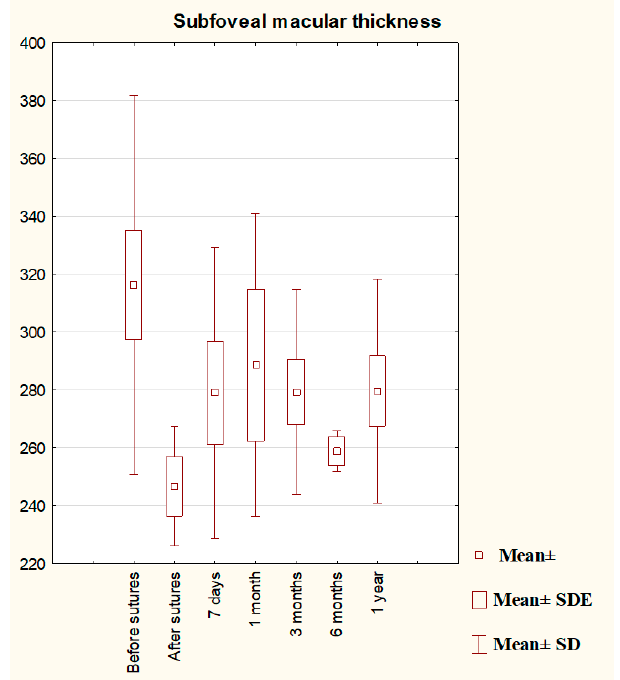
Figure 3. Changes in the subfoveal macular thickness assessed by optical coherent tomography during the study period.